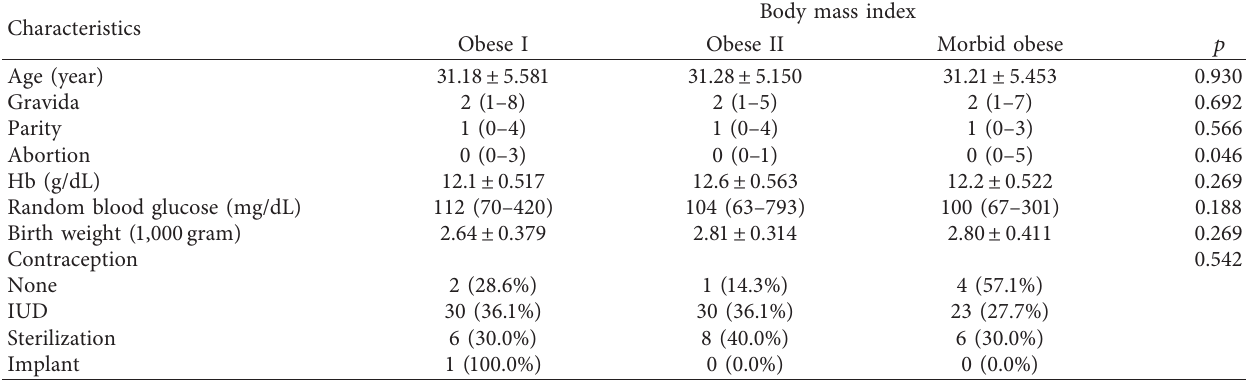
Table 2: Characteristics of subject groups.